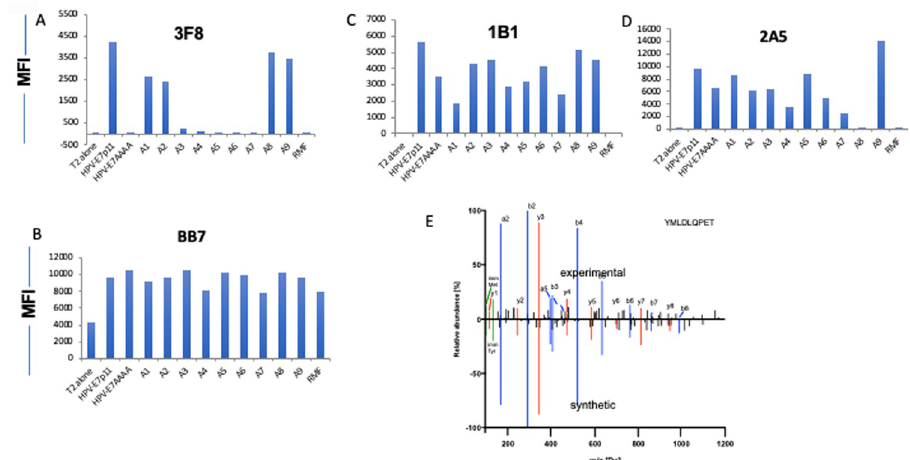
Fig 2. Epitope specificity. The target HPV-E7p11-19 peptide sequence or the same sequence substituted with alanine at positions 1, 2, 3, 4, 5, 6, 7, 8, 9 indicated as A1 to A9, respectively, and pulsed onto T2 cells at 20ug/ml. The HPV sequence with the 4 middle amino acids substituted with alanine [HPV-E7AAAA] as used to gage binding to the center of the sequence as well. The binding of the mAbs 3F8 [A], 1B1 [B], or 2A5 [C] at a concentration of 3ug/ml was determined by flow cytometric analysis. T2 cells alone, or pulsed with RMF irrelevant peptide were the negative controls. The same cells were simultaneously stained with anti-HLA-A2 mAb, clone BB7.2, to measure the relative binding of the peptides to HLA-A2 molecule [D]. The data represent one of two similar experiments. [E]. Mirror plot of synthetic [bottom] and cell-derived experimental [top] YMLDLQPET peptides. Relative abundance refers to peak areas which are normalized to maximum peak.